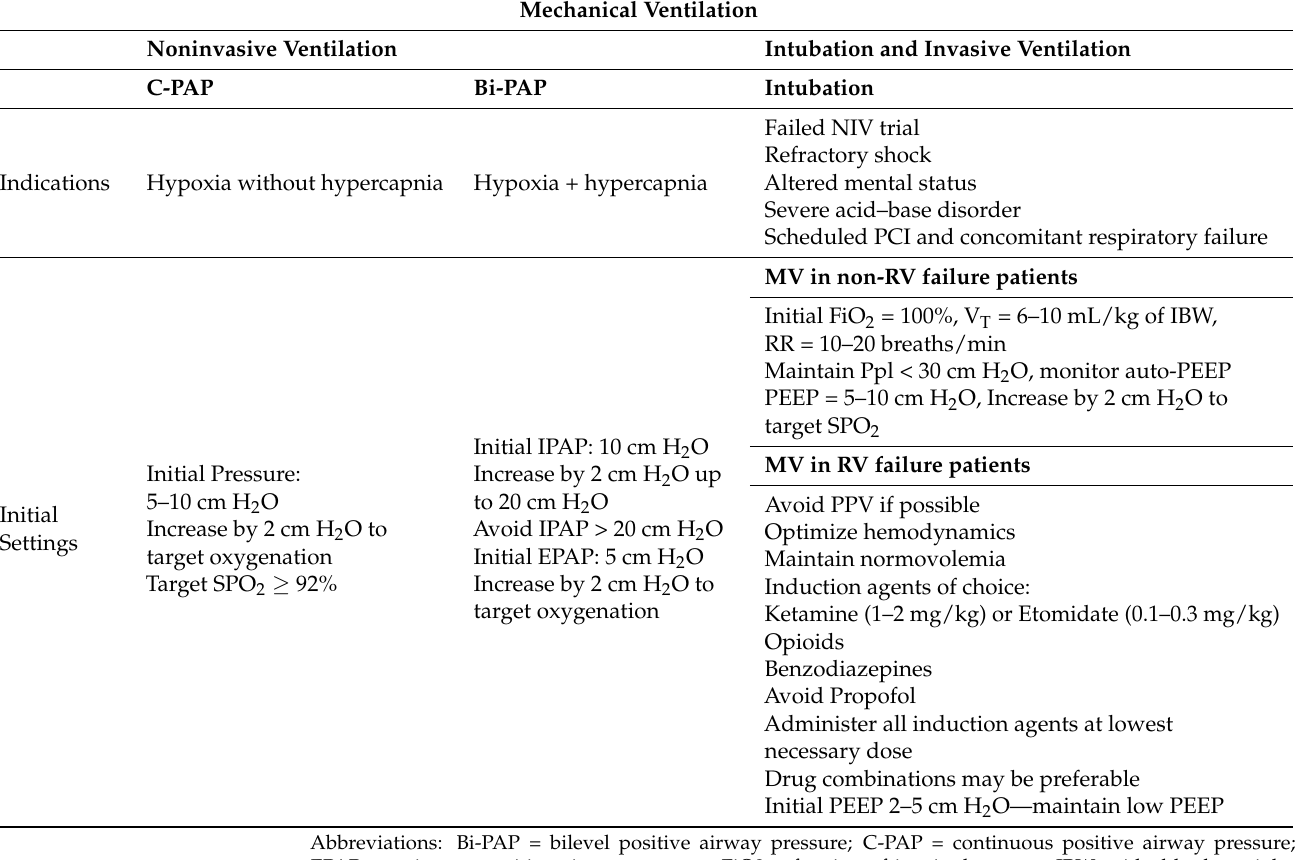
Table 3. Indications and initial settings for both noninvasive ventilation (NIV) and invasive mechani- cal ventilation (IMV)